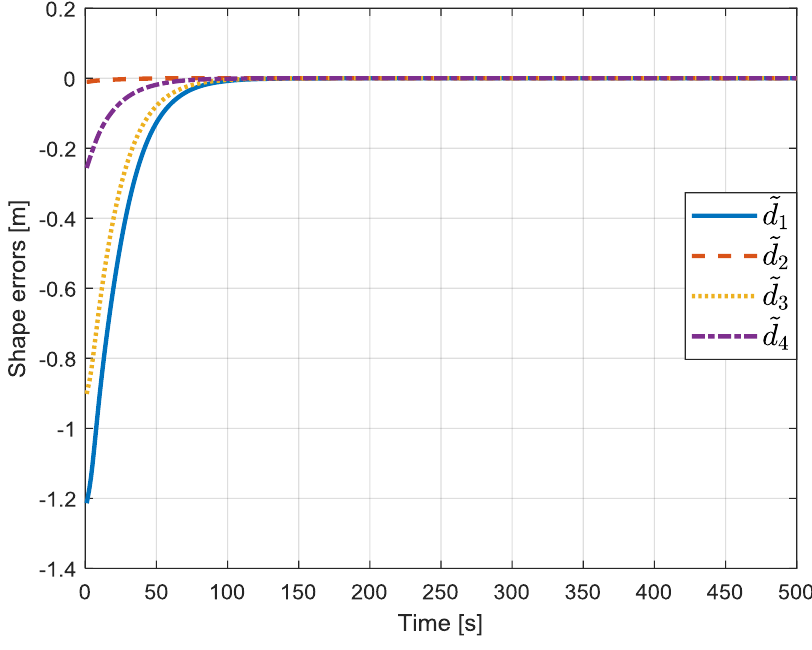
Figure 11. Shape errors of the leader